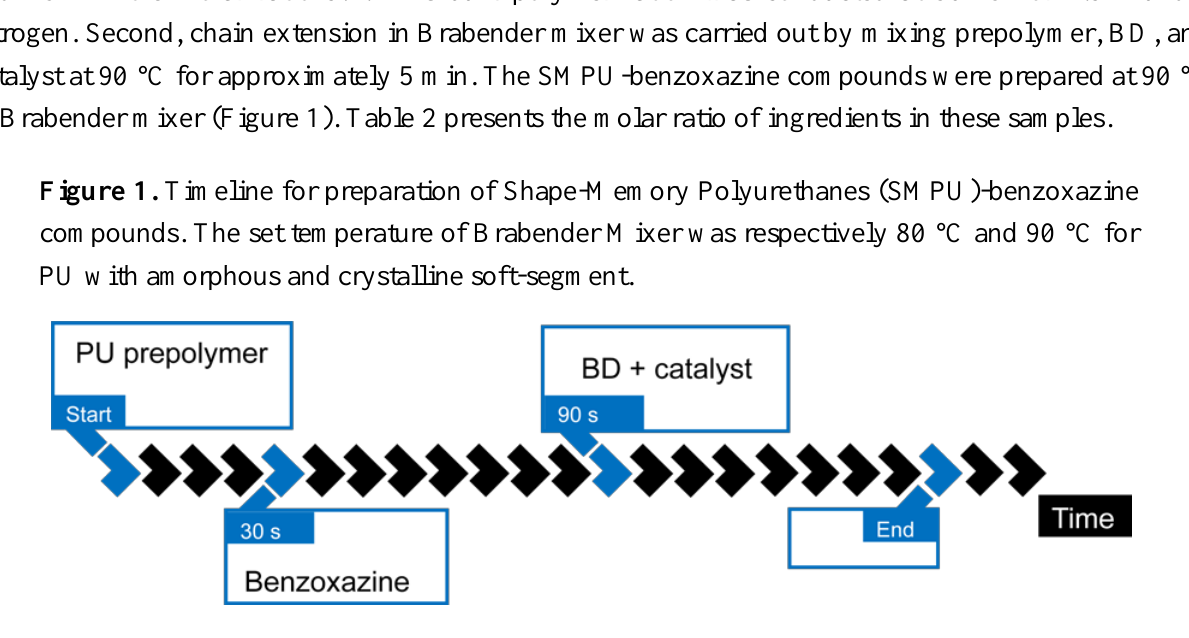
Table 2. Molar ratio of ingredients, hard segment content (HSC) and weight percent of benzoxazine in SMPU with crystalline